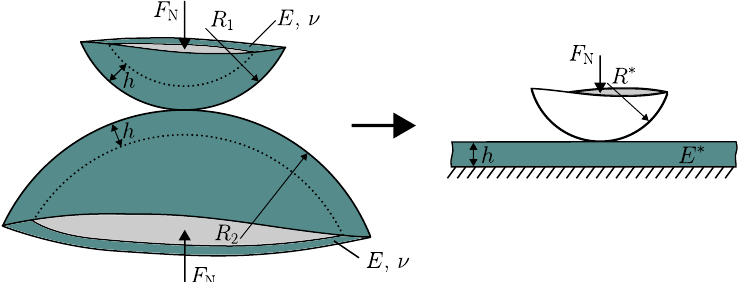
Figure 2. Contact of two differently curved rigid bodies with equal coatings and equivalent problem of a curved rigid body and a